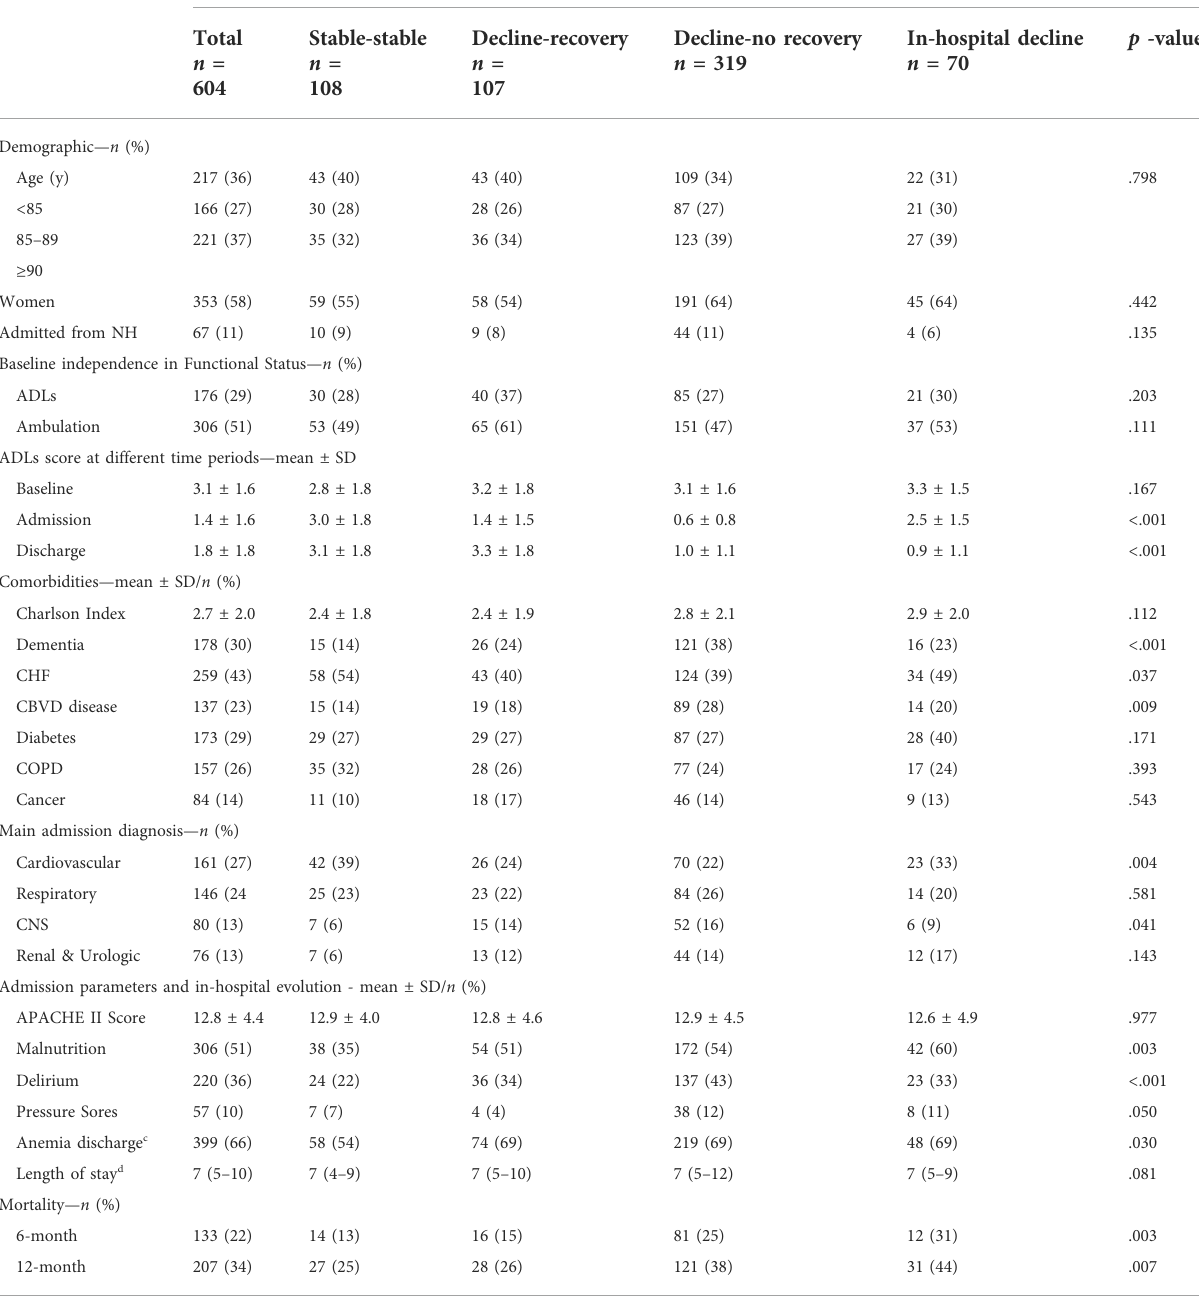
TABLE 1 Baseline, In-Hospital Characteristics, and Mortality Rate of the 604 Patients and its Strati fi cation According to Functional Trajectories a .